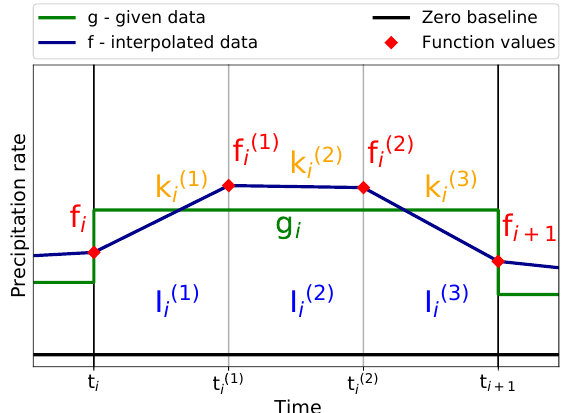
Figure 5. Schematic overview of the basic notation in a precipita- tion interval with the original precipitation rate g (green) as a step function and the interpolated data f (dark blue) as the piecewise linear function. The original time interval with fixed grid length (cid:49)t is split equidistantly in three subintervals denoted by I ( 1 , 2 , 3 ) , with i the slopes in the subintervals as denoted by k ( 1 , 2 , 3 ) . The sub-grid i function values f i , f ( 1 , 2 ) , f i + 1 are marked by red i